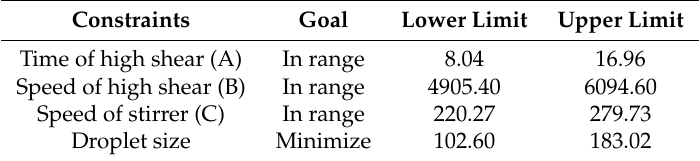
Table 5. Constraints of numerical optimization.